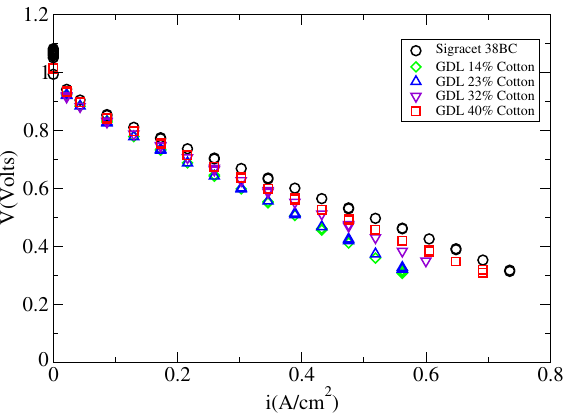
Figure 2. Polarization curves with gas diffusion layer of different cotton fiber content and Sigracet 38BC.